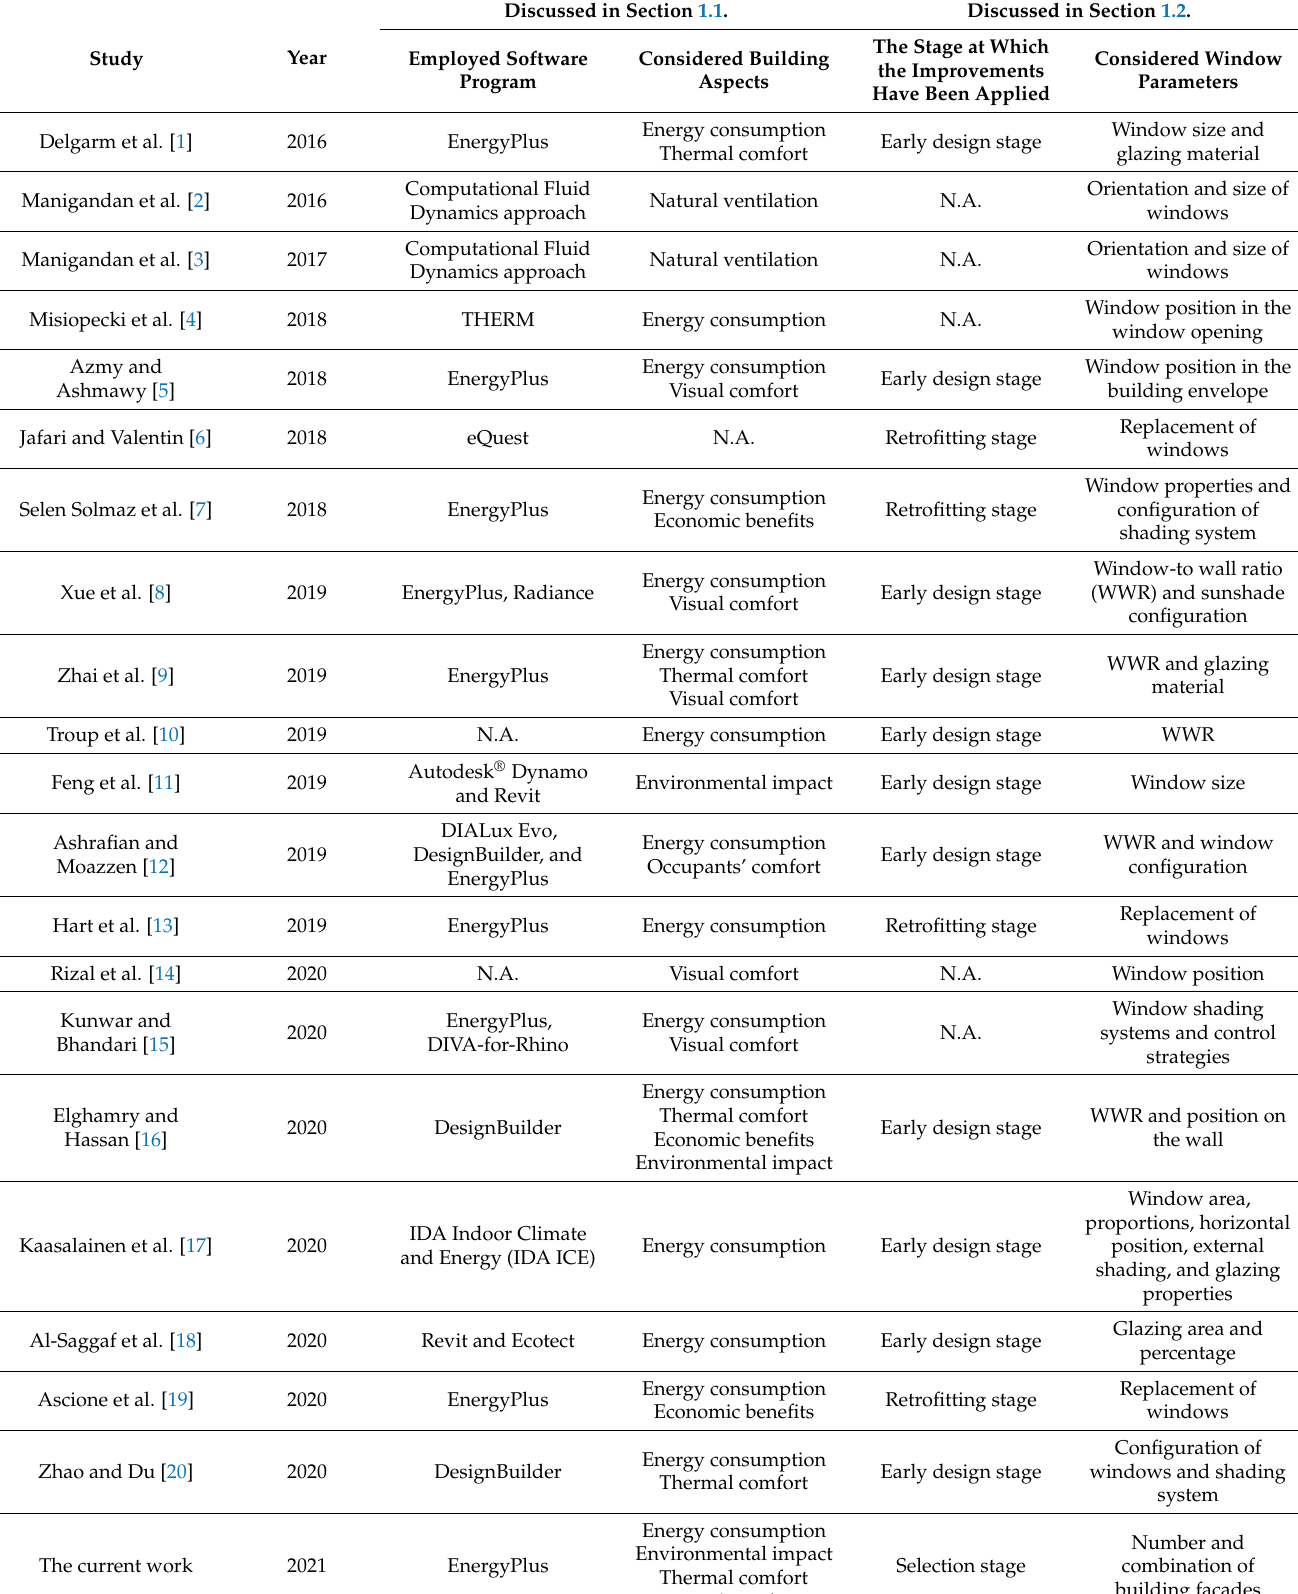
Table 1. A list of the recent works which have been carried out in the field of improving building